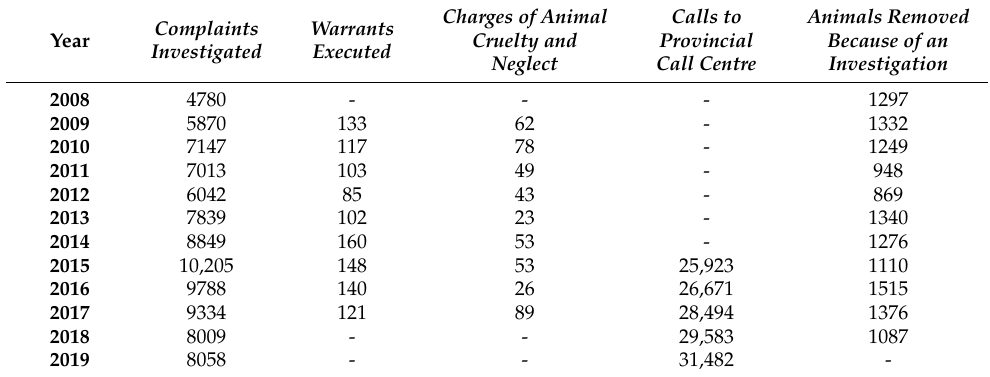
Table 3. Statistical Data from British Columbia. Information compiled from BC SPCA Annual Reports.